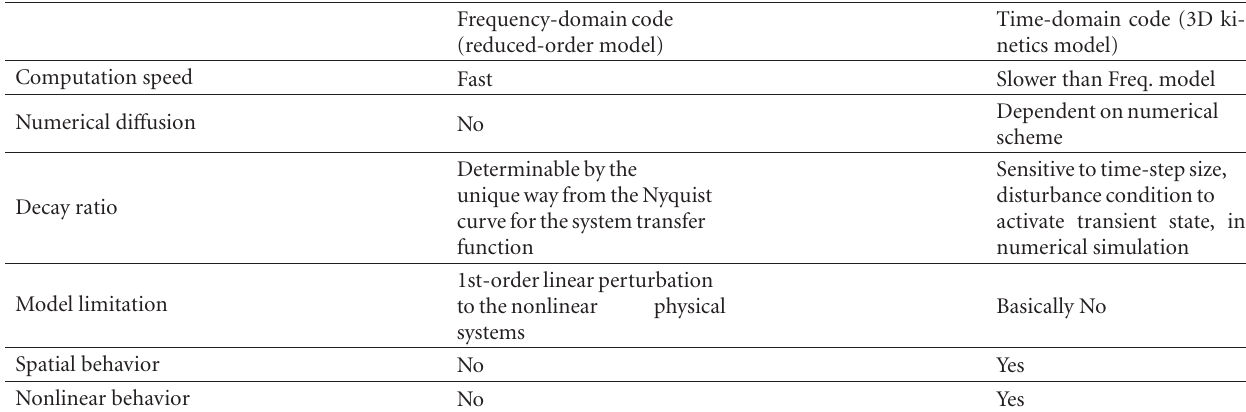
Table 1: Features in frequency-domain and time-domain stability analysis